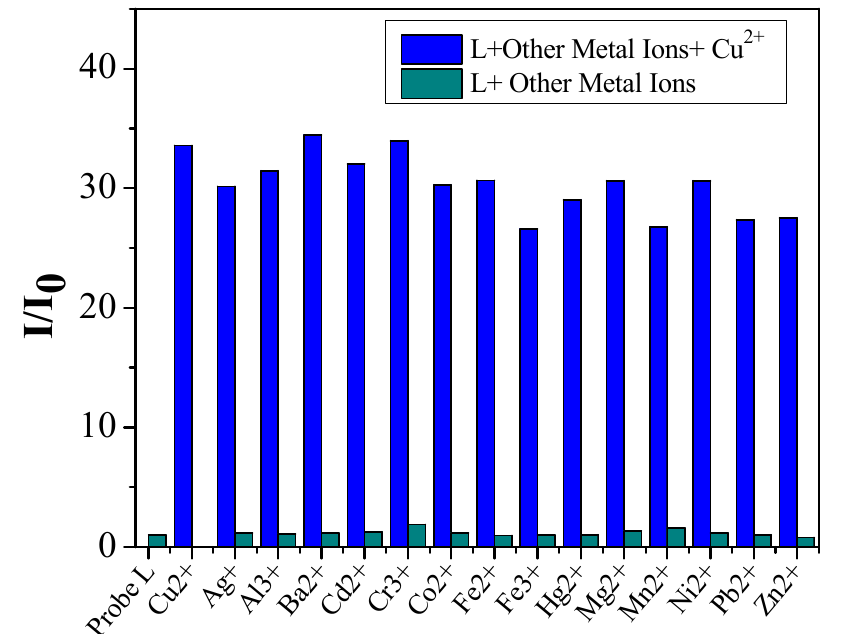
Figure 4. Relative fluorescence intensity of L (10 µ M) in ethanol–water ( v / v = 7/3, 5 mM HEPES, pH 7.0) to various competitive metal ions. (Green bars) and relative fluorescence of L in the presence of 15 µ M of potential competitive metal ions after subsequently adding 5 µ M Cu 2+ . (Blue bars) (at λ ex = 380 nm with excitation slit = 5 nm and emission slit = 5 nm.).